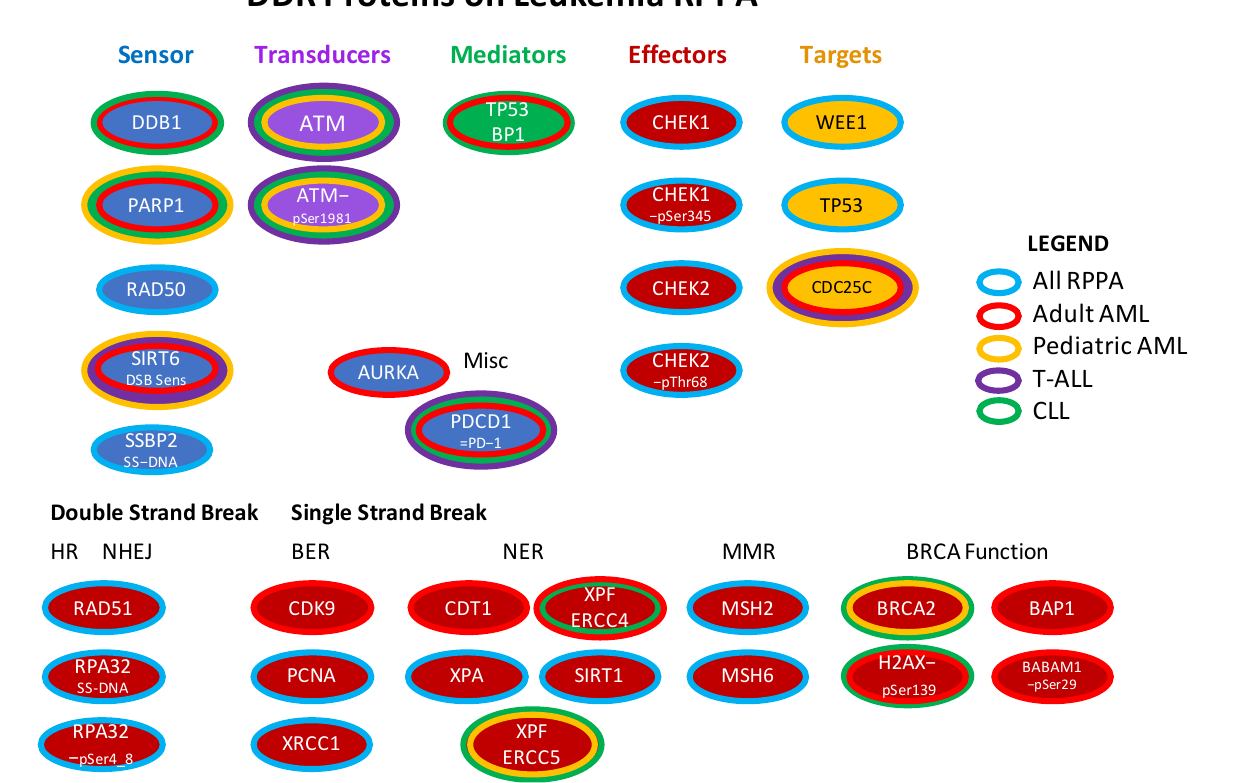
Figure 1. DDR proteins included in the four leukemia RPPA arrays. The DNADR and DDR-related proteins that were assessed in the four RPPAs (adult AML, pediatric AML, T-ALL, CLL) are shown arranged as per the organization in Figure 1 of Esposito and So [5], or classified by whether they are effectors of double or single strand break repair. Center color reflects the function as specified below the title. The surrounding band(s) show which array(s) they were printed on: blue [on all four arrays], red [adult AML], yellow [pediatric AML], green [CLL]. None of the antibodies were unique to the T-ALL RPPA. Repair mechanism abbreviations: HR = homologous recombination. NHEJ = non-homologous end joining. BER = breakpoint excision repair, NER = nucleotide excision repair. MMR = mismatch repair. Figure adapted from Esposito (2014).